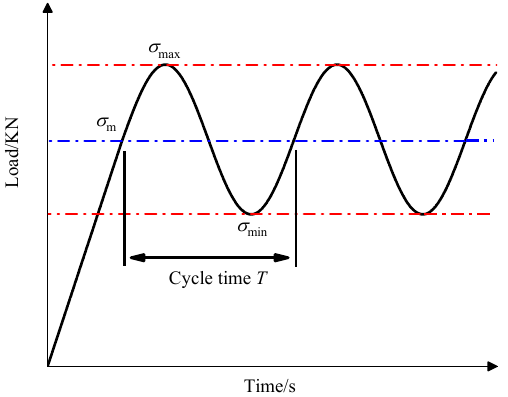
Figure 4. Cyclic disturbance loading.